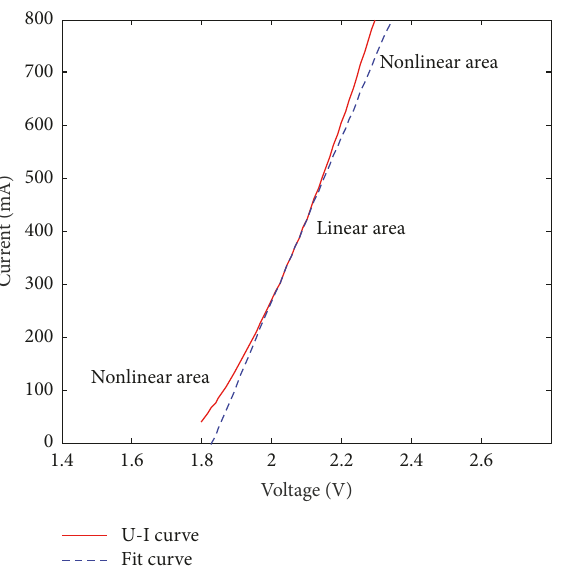
Figure 4: U-I curve of the LED.